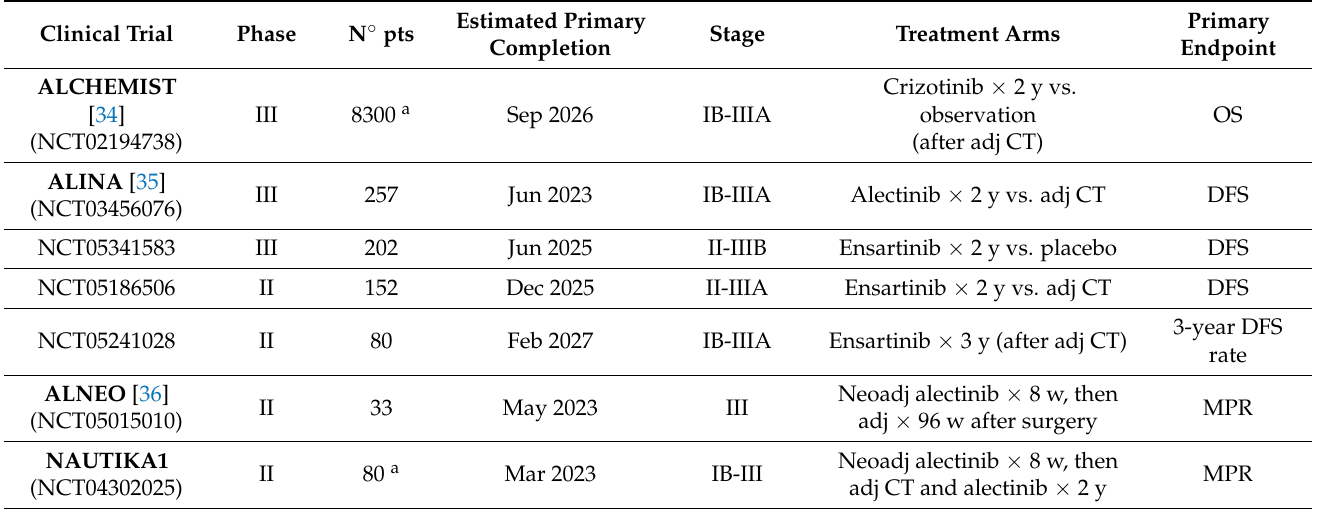
Table 4. Ongoing clinical trials with ALK-TKIs in the (neo-)adjuvant